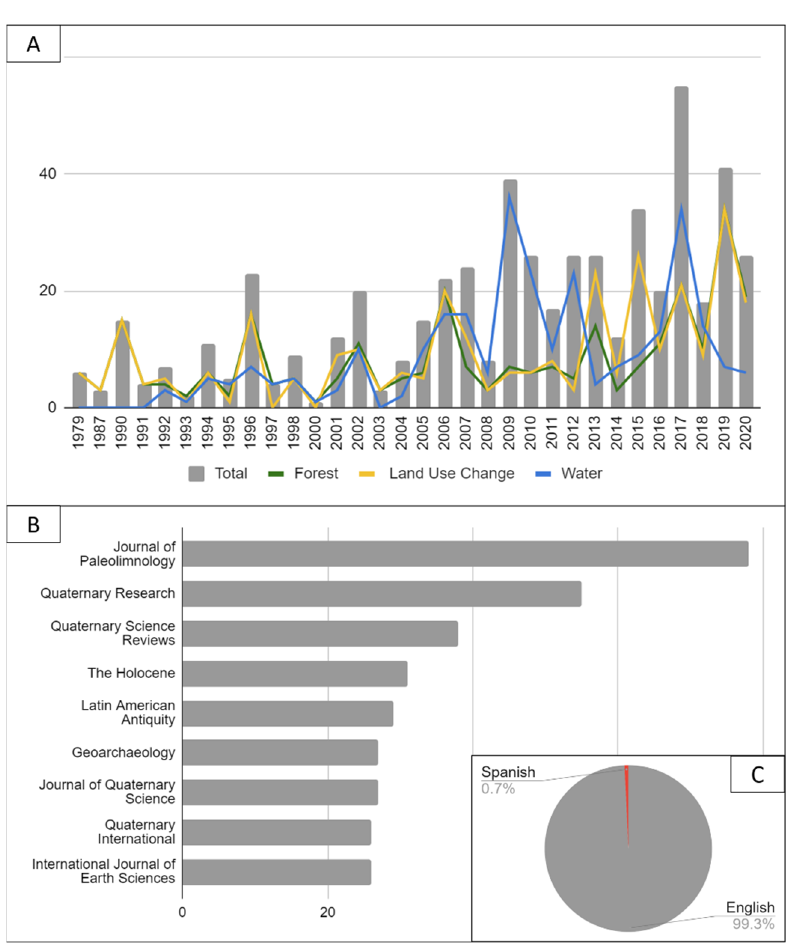
Figure 5. Source of studies presented in the evidence base: (i) Total; (ii) Forest; (iii) Land Use Change; (iv) Water. ( A ) Number of studies by year of publication. ( B ) Number of studies by Journal; ( C ) Published Language.